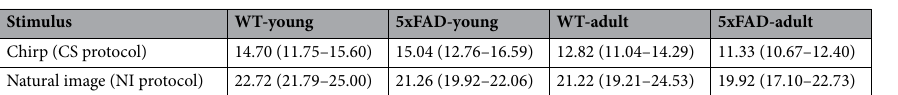
Stimulus WT-young WT-adult